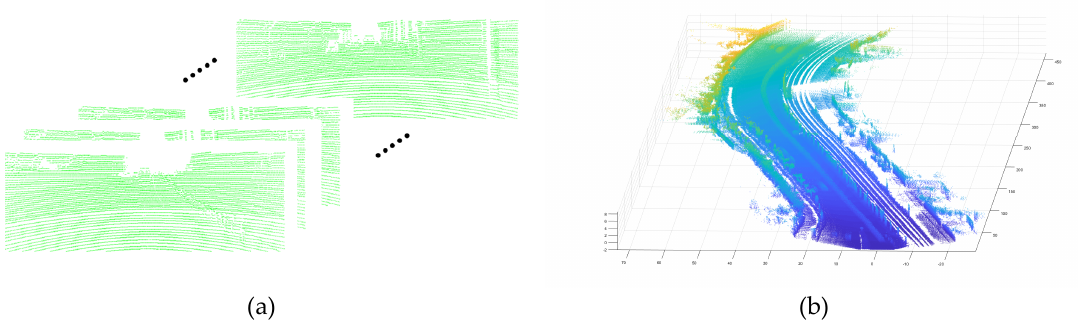
Figure 4. ( a ) Point cloud frames and ( b ) Point cloud map.